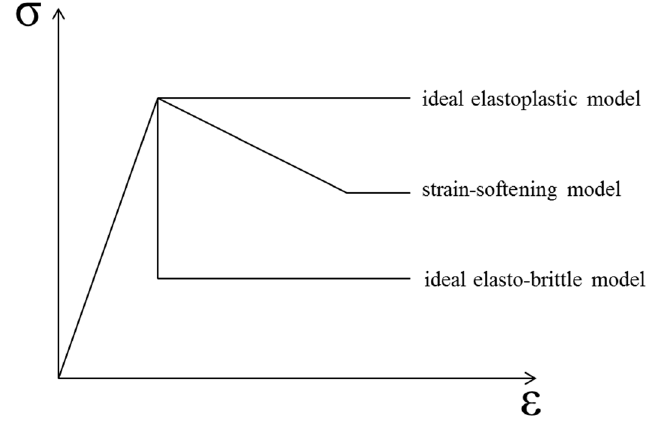
Figure 9. Three typical simplified post-peak curves of rock material. As shown in Figure 10, the stress–strain curves at different ages of shotcrete samples are also visible differently. The stress–strain curve of the sample with a 12-h curing age is more like the typical concrete stress–strain curve, which included three typical stages. The initial stage (elastic stage), secondary stage (plastic stage), and the interior crack began to generate in the mortar during the secondary stage. Subsequently, a visible crack formed in the third stage. To facilitate comparison with specimens of other ages, a fourth stage, called the post-peak stage, was studied.